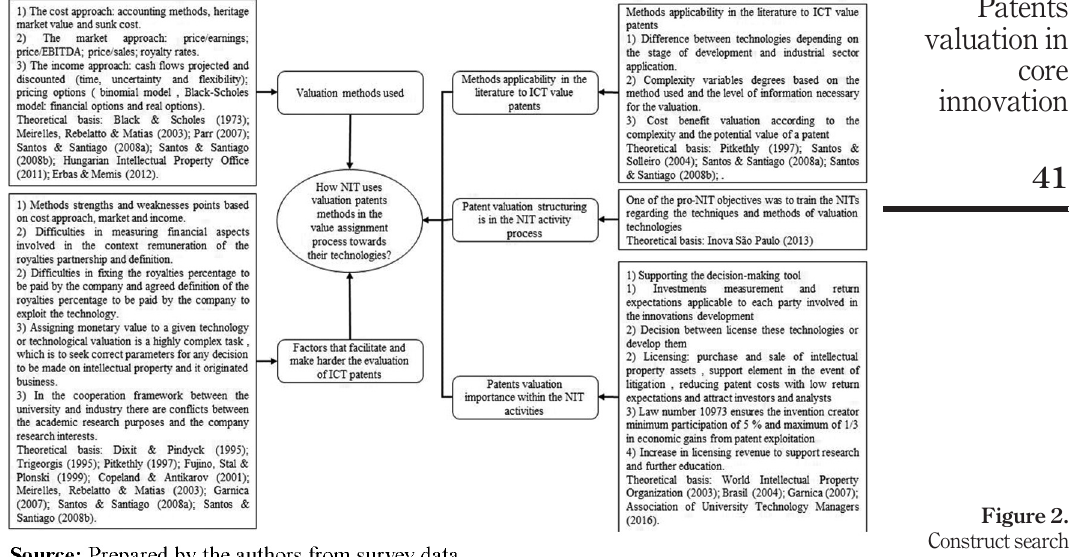
Figure 2. Construct